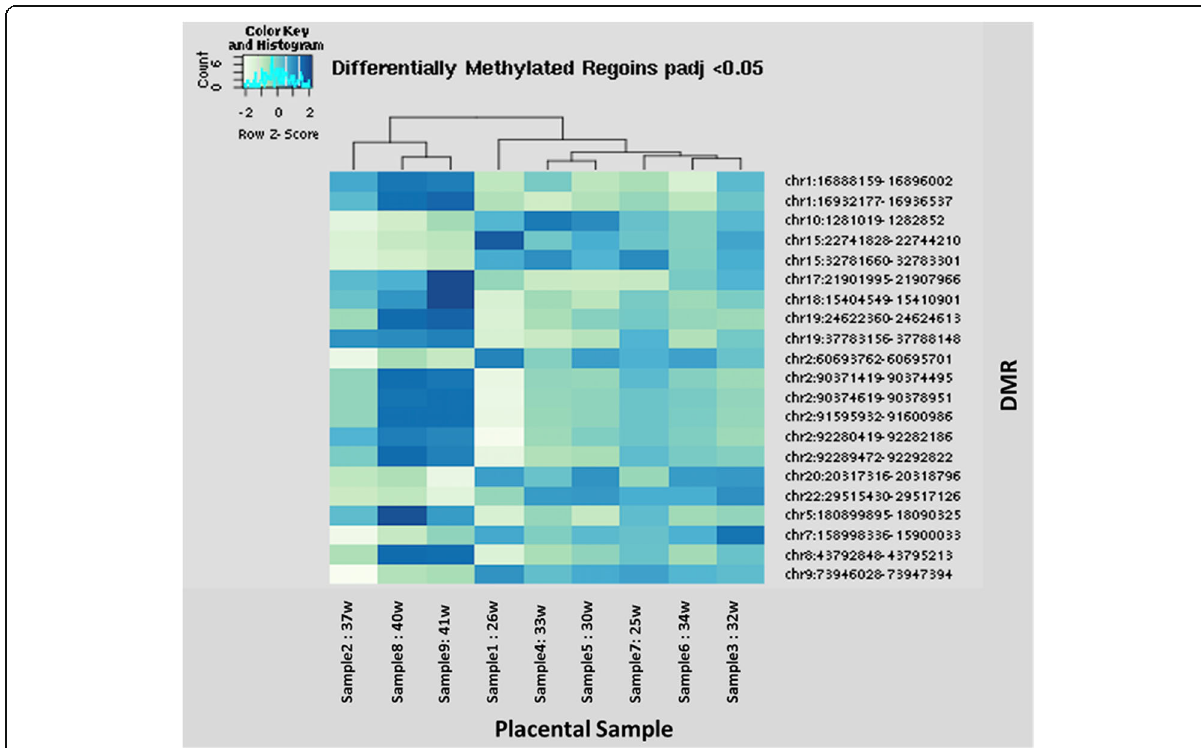
Fig. 1 Peak Intensity heat map: A heat map of the read counts of the 21 DMRs for each of the 9 samples. Samples 2, 8 and 9 are the term placentae, and the remaining is preterm. Unsupervised clustering was used to order the columns. Darker blue squares represent more reads/ higher methylation whereas lighter green squares represent less reads/lower methylation